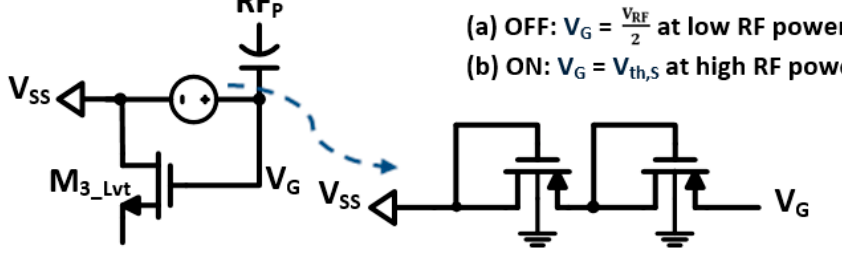
Figure 5. Adaptive biasing technique for the NMOS rectifying transistors.